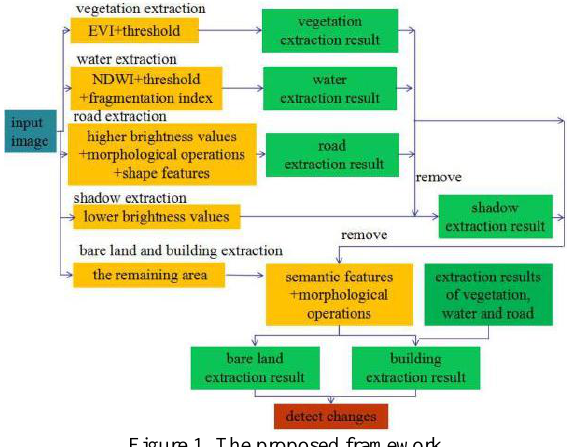
Figure 1. The proposed framework